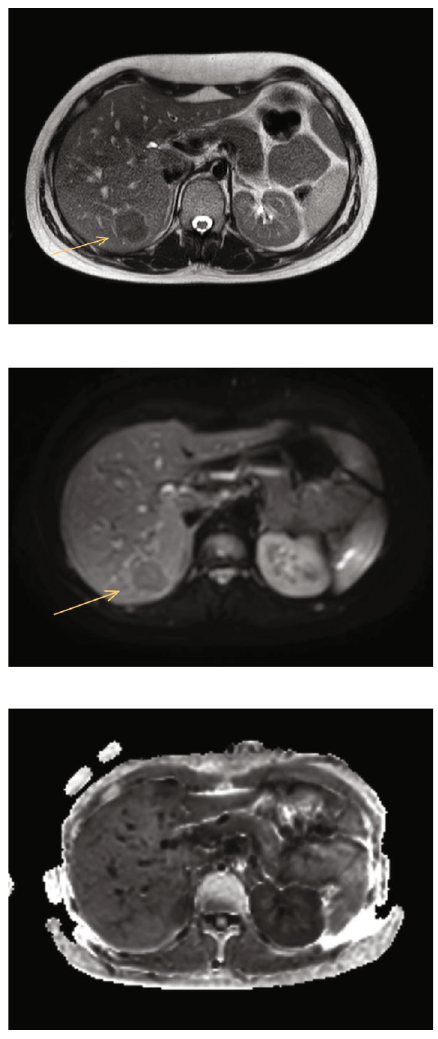
Figure 4: The lesions were isointense in T1-weighted images and hyperintense in T2-weighted images and did not demonstrate any di ff usion